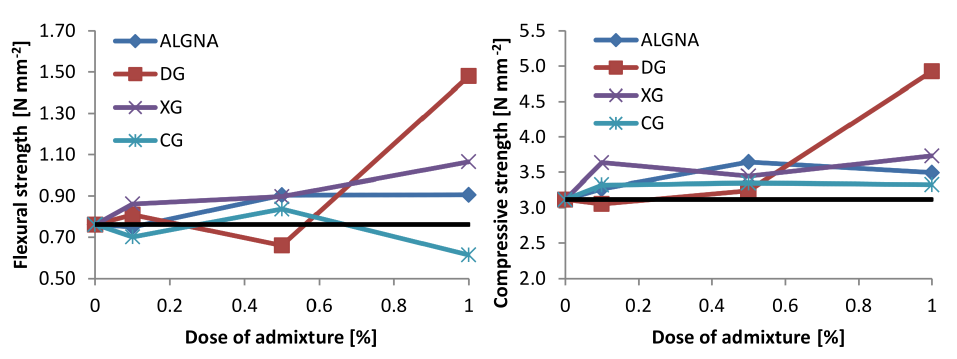
Figure 2. Flexural and compressive strength of mortar specimens 7 days old.